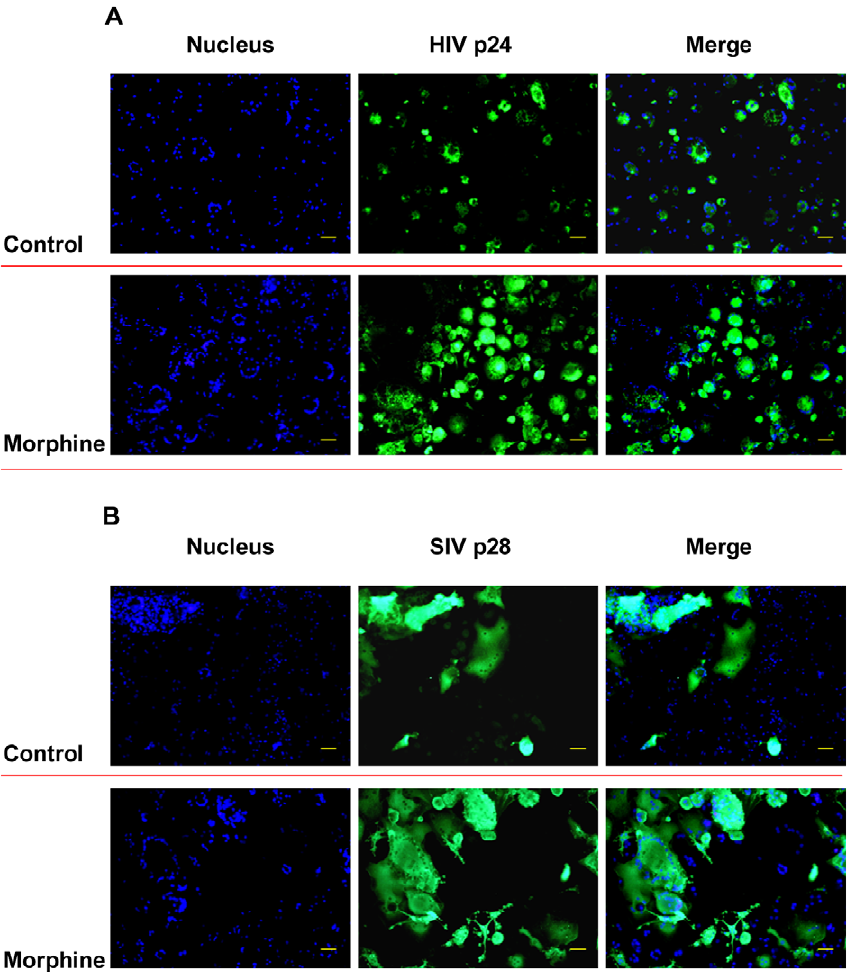
Figure 2. Effects of morphine on HIV p24 protein or SIV p28 protein expression in macrophages. Seven-day-cultured macrophages were treated with or without morphine (10 2 10 M) for 24 h and then incubated with HIV Bal strain or SIV Delta B670 strain for 2 h in the presence or absence of morphine (10 2 10 M). HIV p24 (A) or SIV p28 (B) protein expression in macrophages at day 15 postinfection was determined by immunofluoresence staining with antibodies against HIV p24 or SIV p28 protein (green). The nuclei were stained with Hoechst 33342 (blue) (magnification, 100 6 ; scale bar: 100 m m). doi:10.1371/journal.pone.0031167.g002 PLoS ONE |